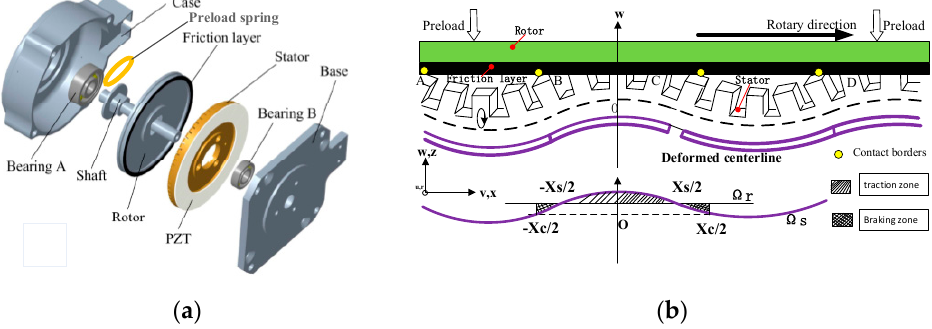
Figure 1. The mechanism of TRUM: ( a ) the motor structure [26]; ( b ) the traveling wave and contact